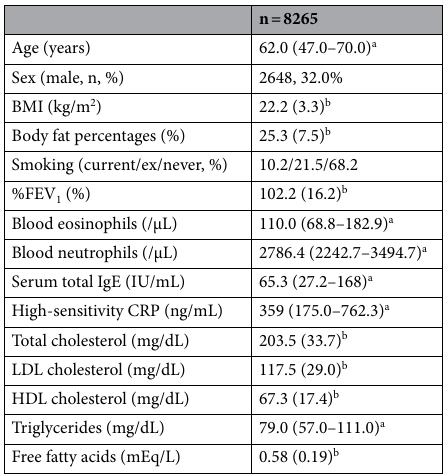
Table 1. Participants’ characteristics. BMI body mass index, FEV1 forced expiratory volume in 1 s. a Median (interquartile range, IQR). b Mean (SD).